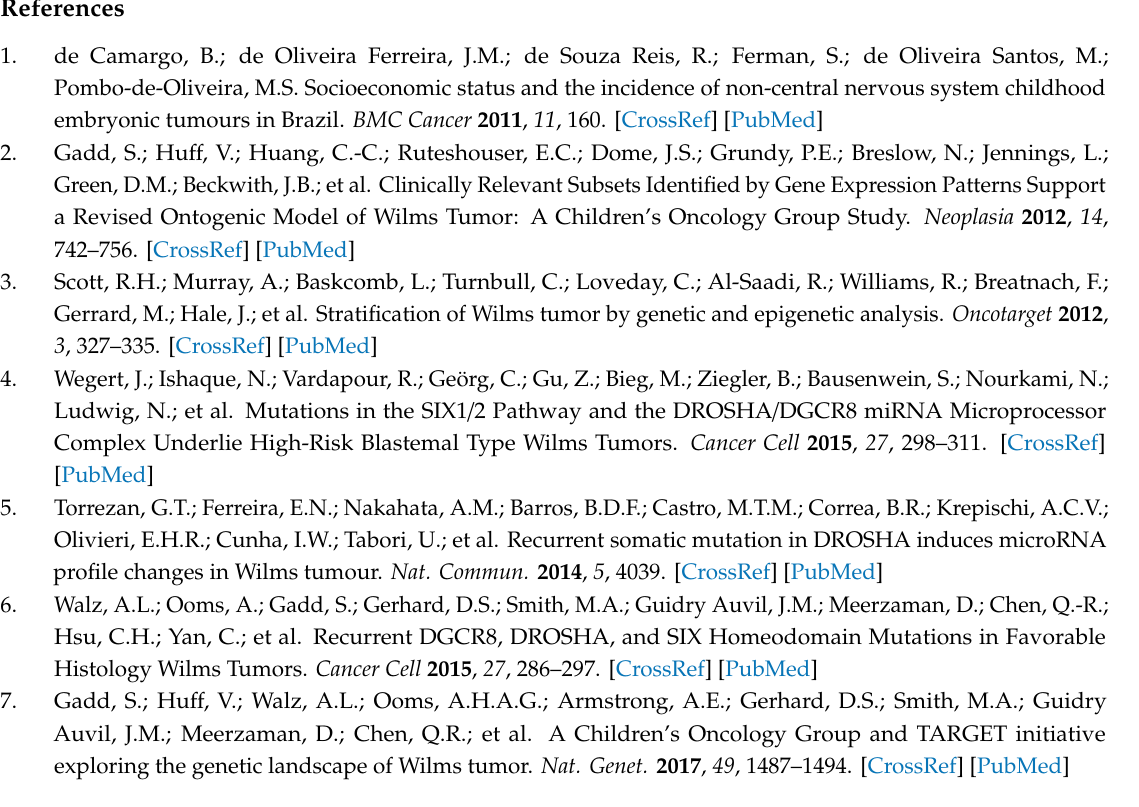
Table S1: Alignment statistics to the reference genome mapping obtained by the STAR program, for paired reads, Table S2: Alignment statistics to the reference genome mapping obtained by the STAR program, for unpaired reads, Table S3: Molecular functions enriched in di ff erentially methylated regions between MT-Group1 and WT by the GREAT software, Table S4: Molecular functions enriched in di ff erentially methylated regions between MT-Group2 and WT by the GREAT software, Table S5: Biological processes enriched in di ff erentially methylated regions between MT-Group2 and WT by the GREAT software, Figure S1: Quality control for Illumina Infinium Human Methylation 450k arrays. (A) Mean detection p -values for each sample. (B) Density ‘bean’ plots (beta-values) for each sample, Figure S2: Density plots (beta-values) for raw data (left panel) and Quantile normalization procedure (right panel), Figure S3: Boxplots of gene expression levels of NK, WT, MT-Group1, and MT-Group2 per gene with negative correlated between methylation and